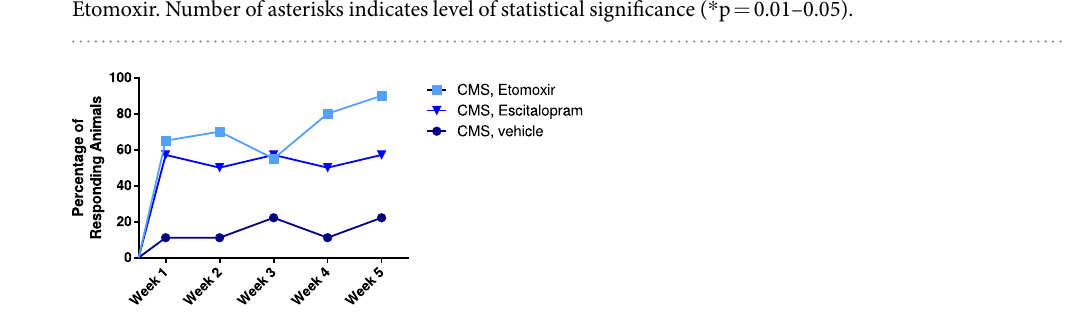
Figure 3. Percentage of responding animals in all five weeks of treatment. Etomoxir or Escitalopram administration reveal similar percentage of responding animals in week one and three, however treatment with Etomoxir shows higher percentage of responders in week two, four and five compared to